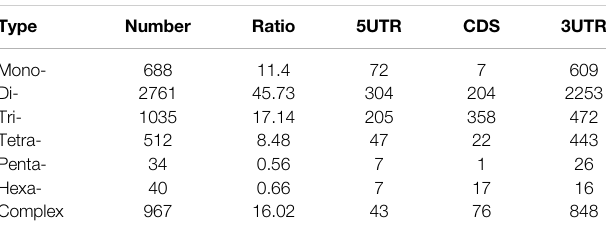
TABLE 2 | Regional distribution of some SSRs in the full-length transcripts of Cipangopaludina chinensis .